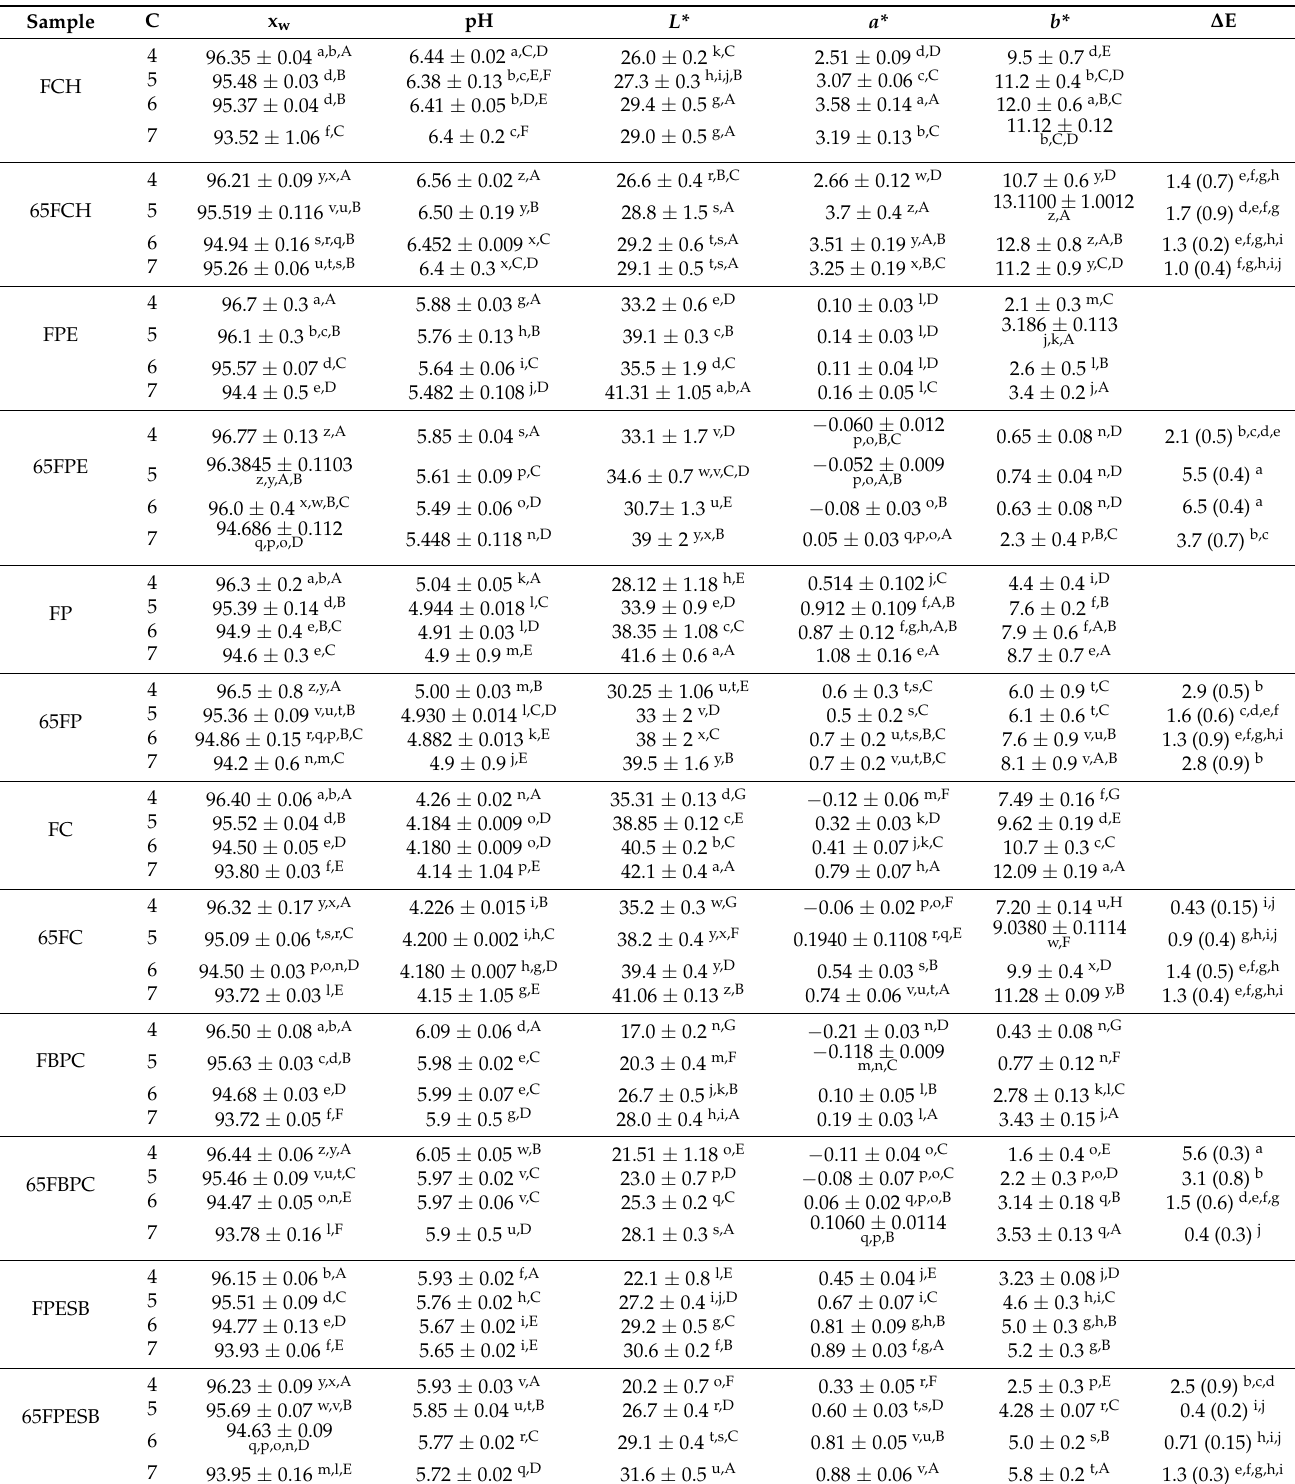
Table 4. Mean values ± standard deviations of the x w (g/100 g sample), pH and color parameters ( L *, a * and b *) of the formulated